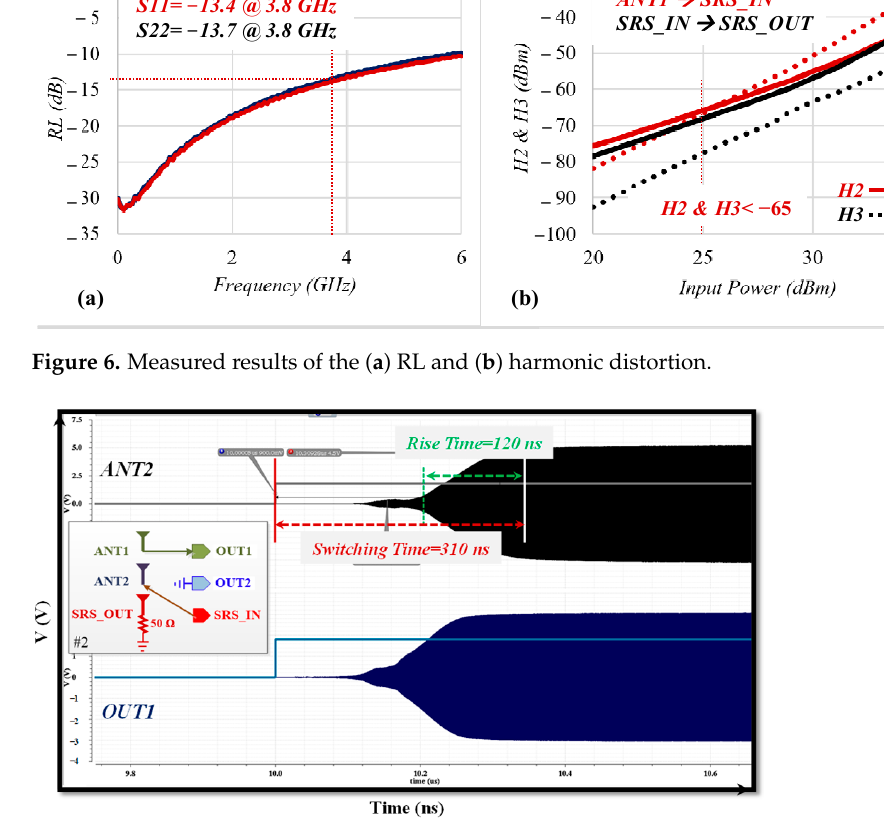
Figure 7. Simulation result of the switching time for switching case of 2.